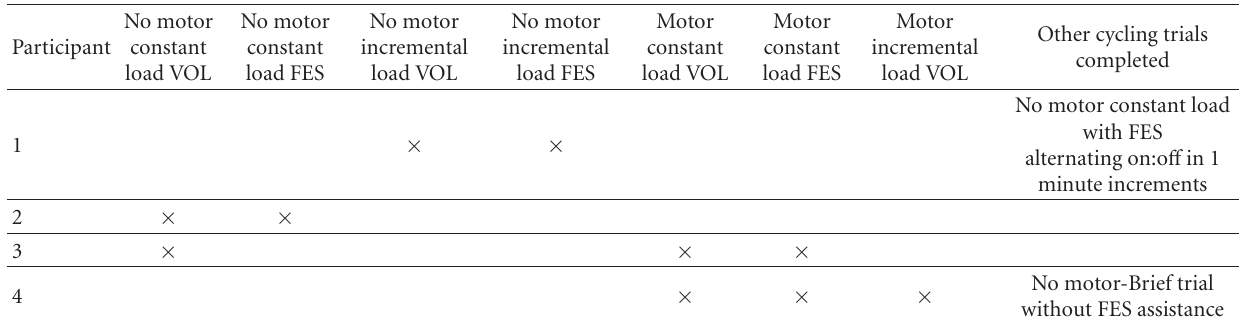
Table 3: Overview of Tests Completed by Each